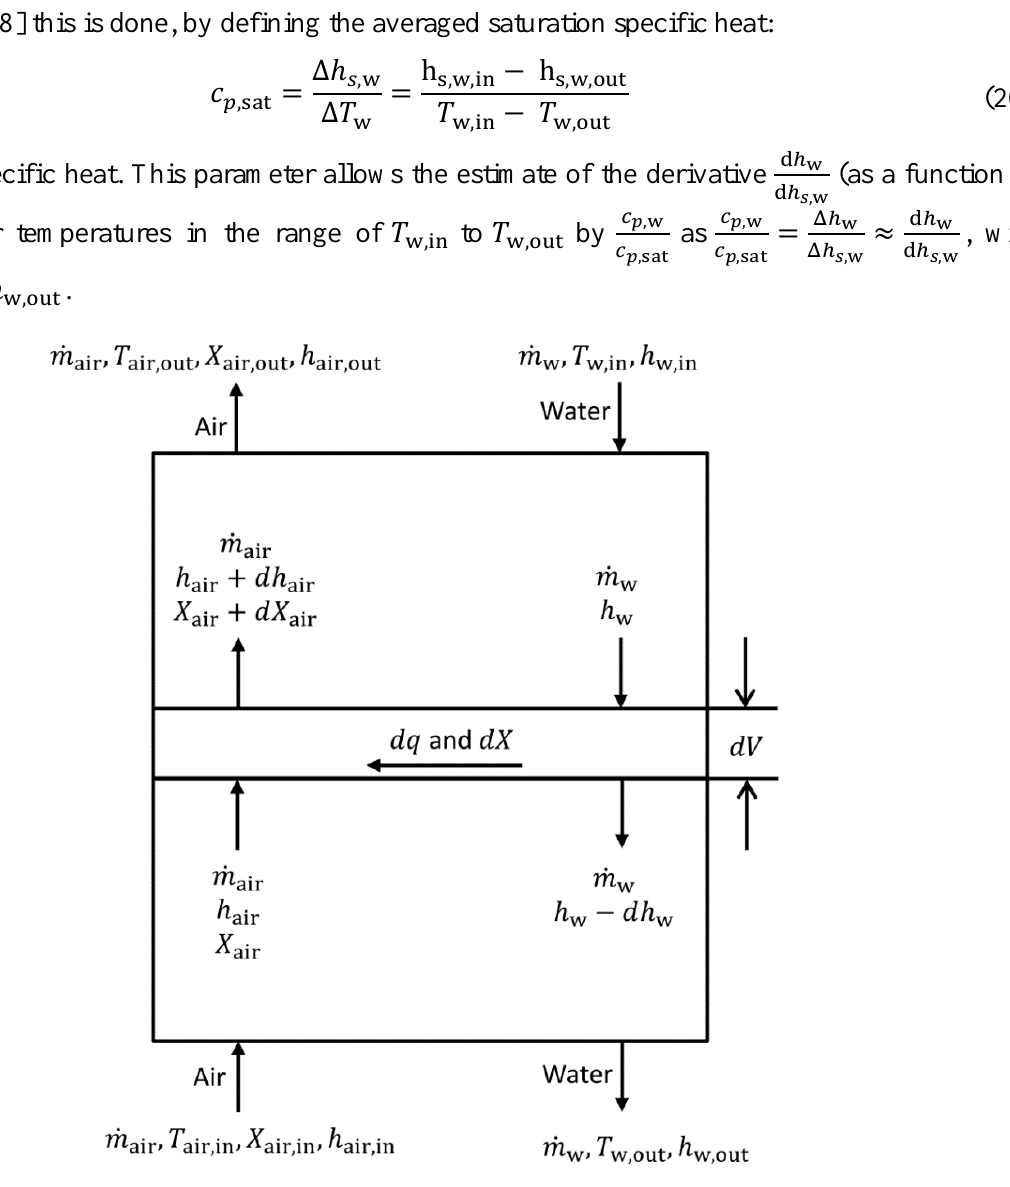
Figure 9. Mass and energy balance of a wet counter flow cooling tower ( cf .